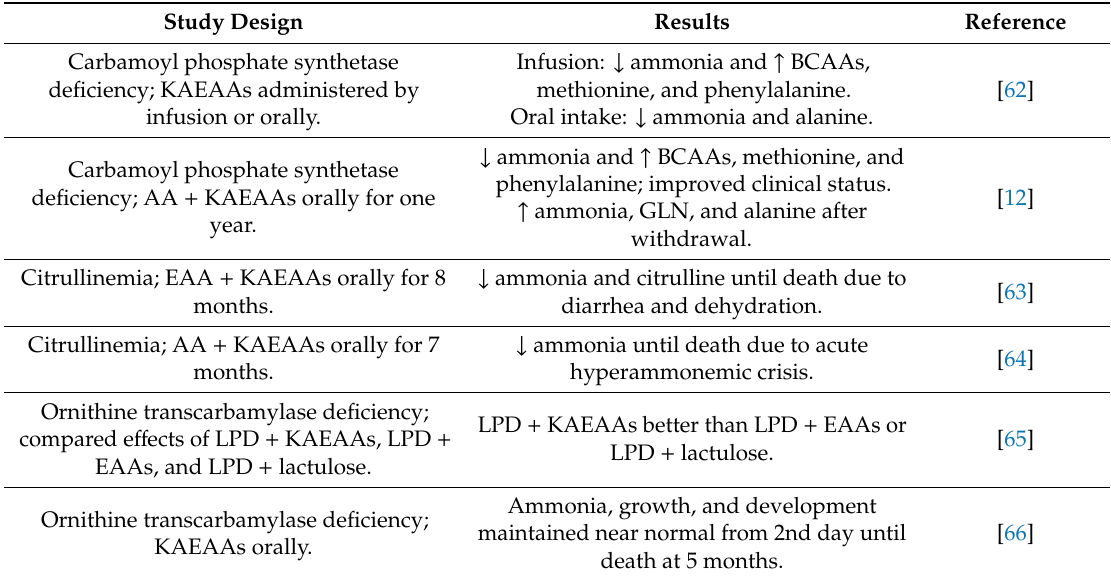
Table 2. E ff ects of KAEAAs in urea cycle disorders